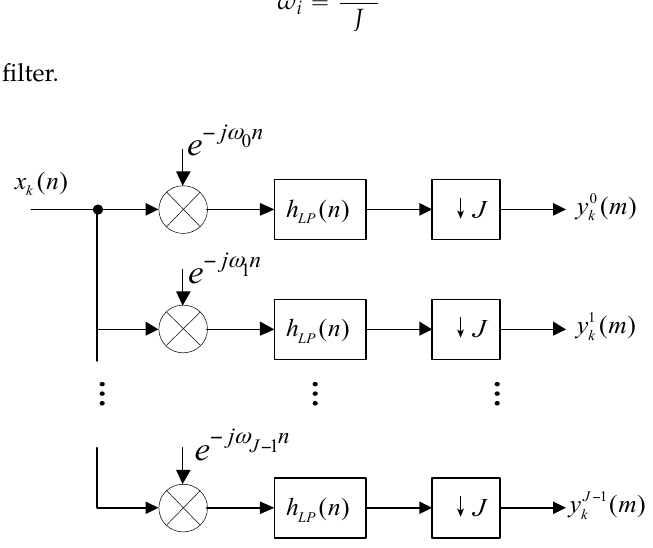
Figure 1. Digital channelization receiver architecture.